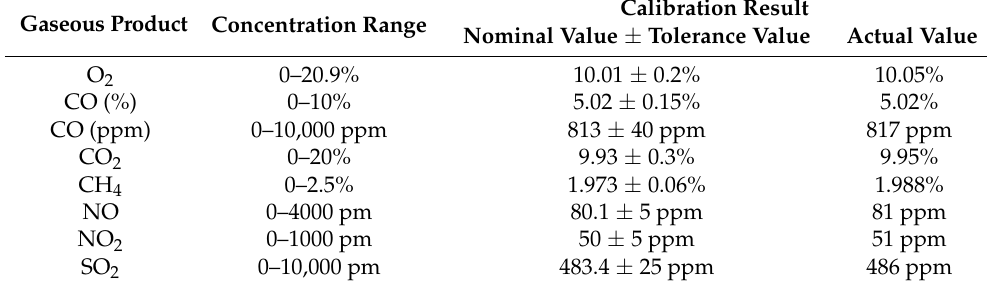
Table 1. The specific measurement range of the corresponding components.